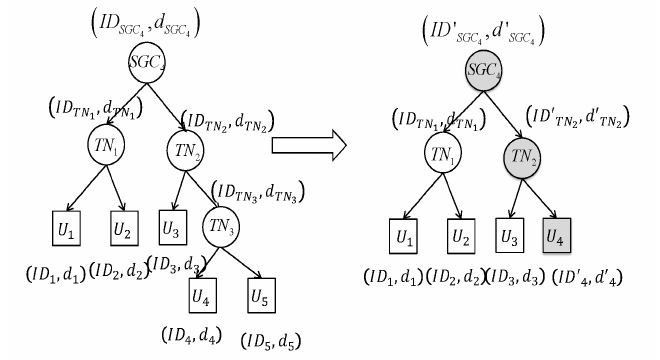
Figure 4. Group member